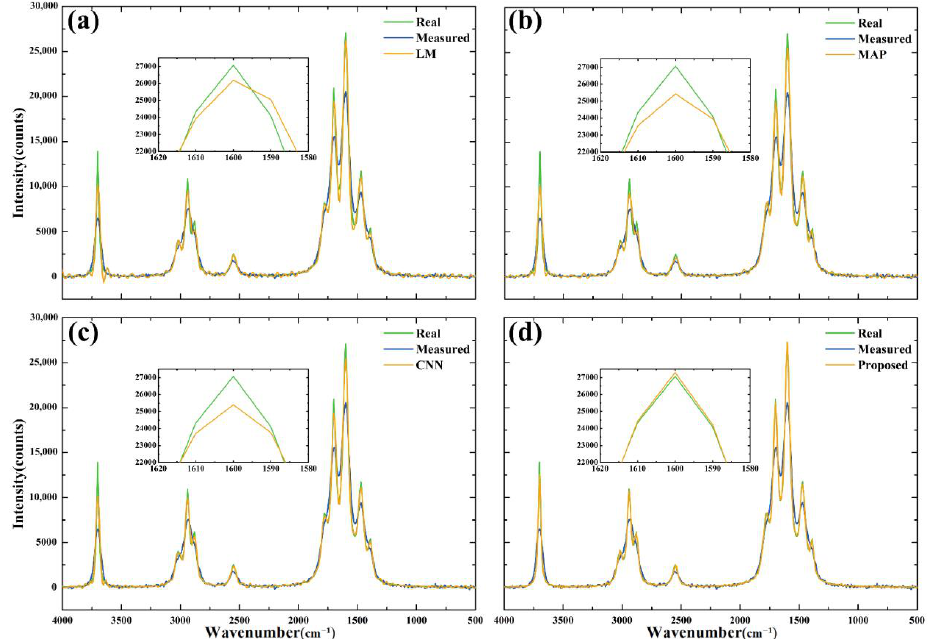
Figure 3. Reconstruction results of the Raman spectrum by several methods. ( a ) the LM method; ( b ) the MAP method; ( c ) the CNN method; ( d ) the proposed method.